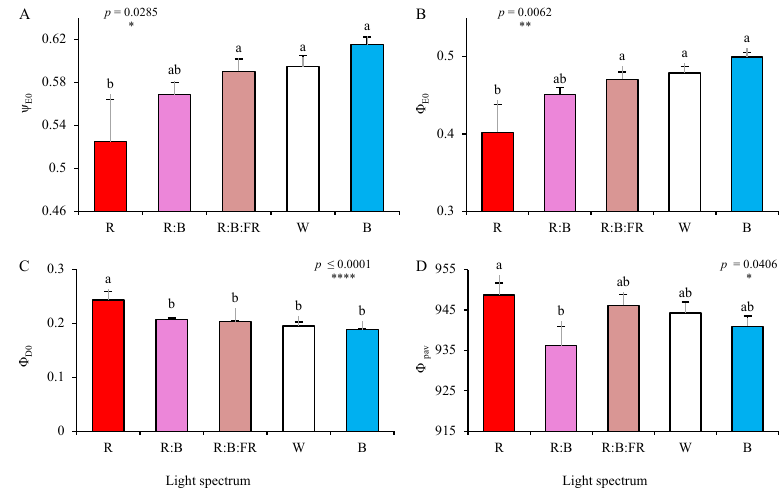
Figure 7. The probability that a trapped exciton moves an electron into the electron transport chain beyond Q − A ( ψ E0 ; A ), Φ E0 ( B ), Φ D0 ( C ), and Φ pav ( D ; equations and explanations in Table 2) of chrysanthemum cuttings exposed for 30 days to different light quality regimes (red (R), red and blue (R:B), red, blue and far-red (R:B:FR), white (W) and blue (B); see the spectrum in Figure 9). Six replicates per treatment were assessed. Columns with the same letters are not significantly different at p ≤ 0.05, according to Duncan’s multiple range tests. Bars represent SEM.